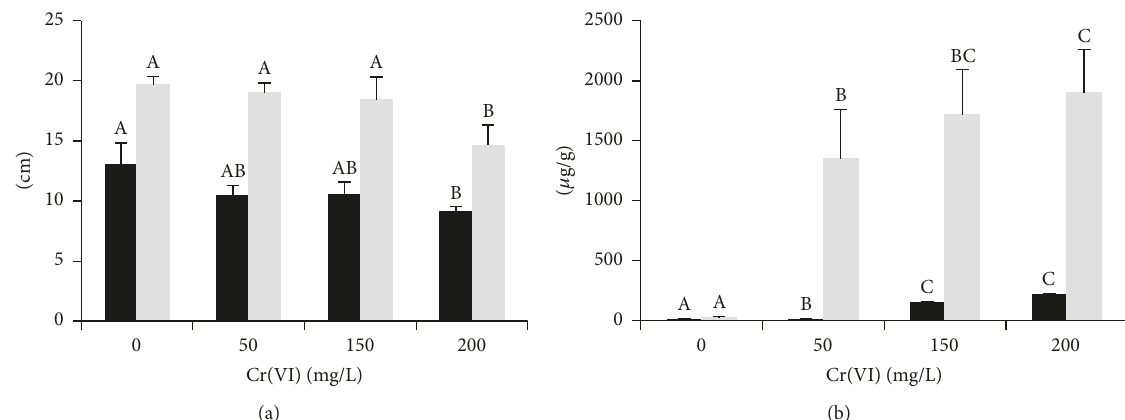
Figure 1: Cr(VI) effect on lettuce shoot (black bars) and root (grey bars) (a) growth (cm) and (b) Cr accumulation ( 𝜇 g/gDW). Different letter means significant differences relative to the control ( 𝑝 < 0.05